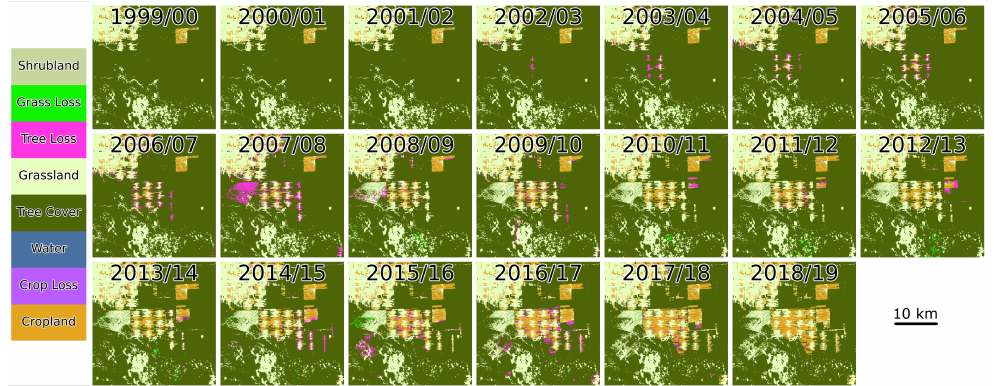
Figure 9. Annual land cover estimates in the Chiquitania lowlands, Bolivia, illustrating expansion of cropland and herbaceous cover at the expense of tree cover loss. The land cover legend is the same as the legend used in Figure 6. However, here we include additional categories to illustrate change: e.g., tree cover loss and herbaceous cover loss from time A to time